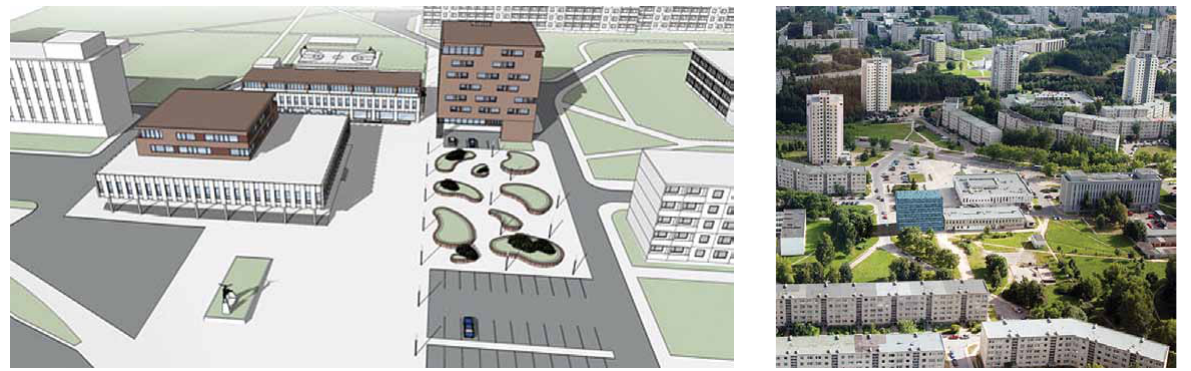
Fig. 7. Public Space Transformation Proposal to build additional buildings in lazdynai residential